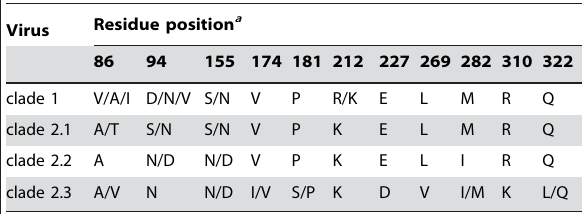
Table 4. Residue diversities between the HA1 sequences of Vietnam H5 hemagglutinins from H5N1 avian influenza